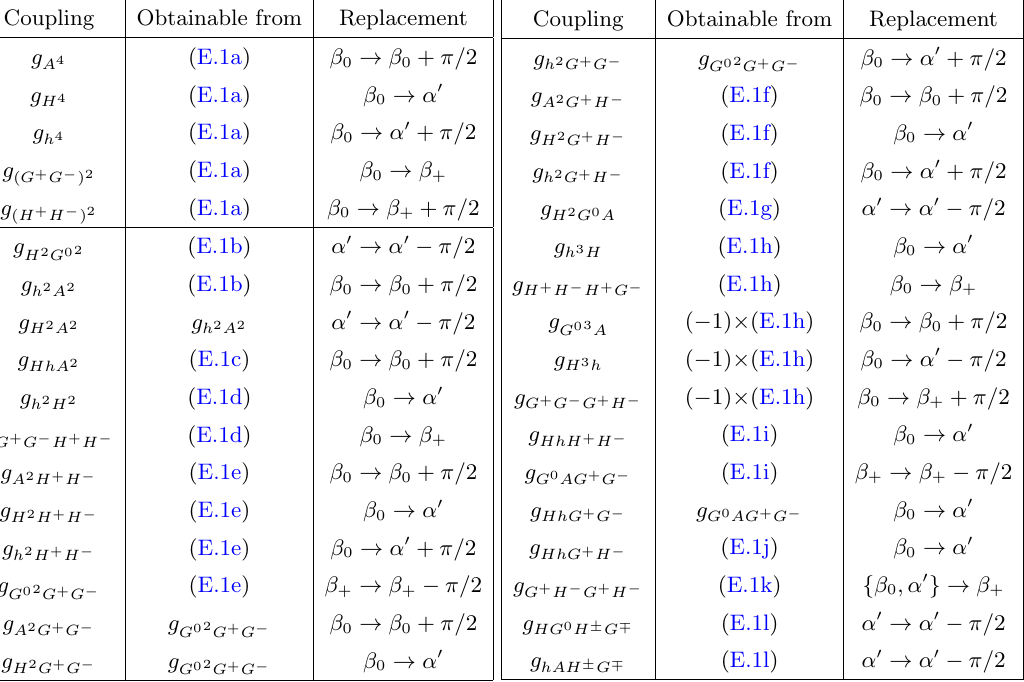
Table 2 . Quartic couplings obtainable from reparametrization